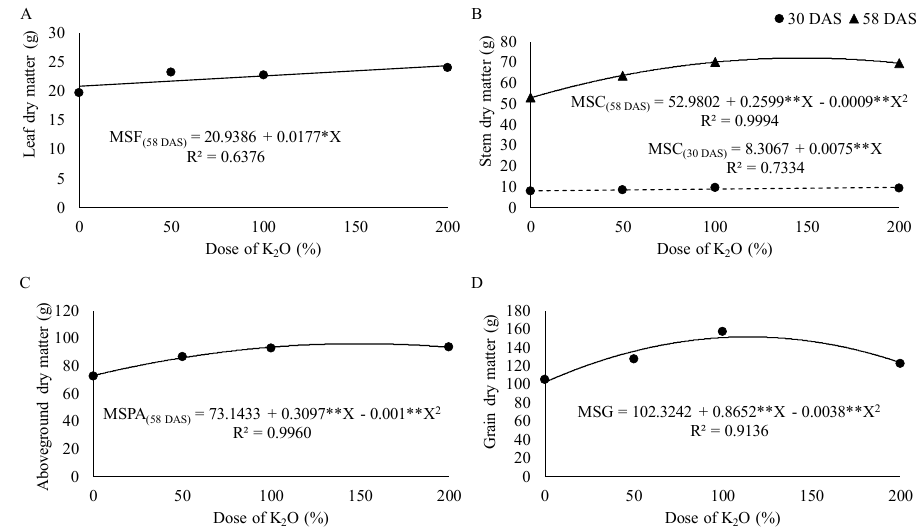
Figure 1. Leaf dry matter (MSF) at 58 days after sowing (DAS) ( A ), stem dry matter (MSC) at 30 and 58 DAS ( B ), aboveground dry matter (MSPA) at 58 DAS ( C ), and grain dry matter (MSG) ( D ) as a function of potassium doses. Rio Verde, Goias, 2019–2020 gowing season. ** and *: significant at 1% or 5% probability. According to variance analysis (ANAVA), there was an effect of interactions between potassium doses × sources for MSF and MSPA at 30 and 86 DAS, MSC at 86 DAS and MSSBG.